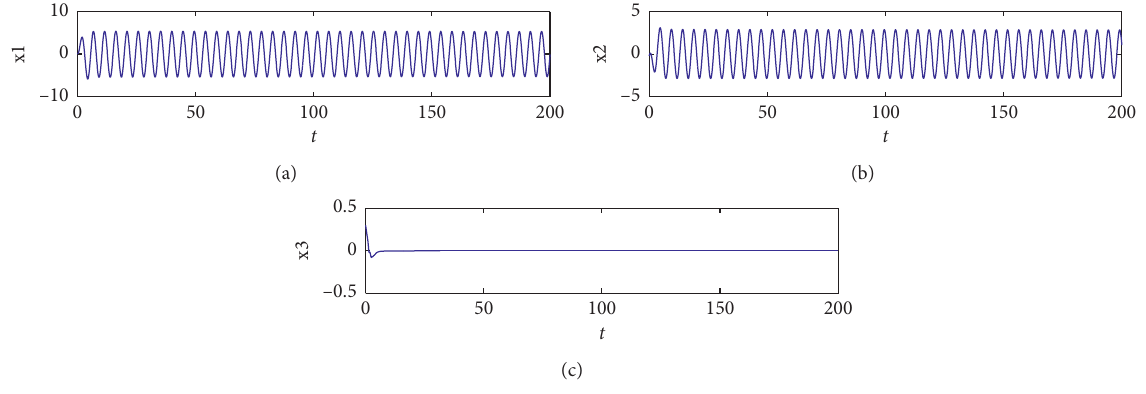
Figure 3: System (31) is unstable with α �